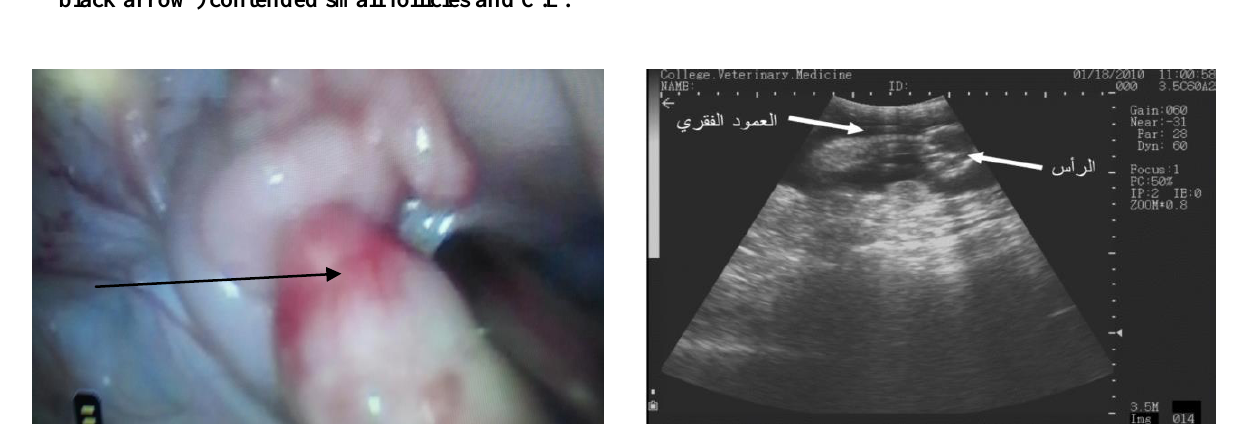
Figure,8: Ultrsonographic image of goat uterus at 40 days of